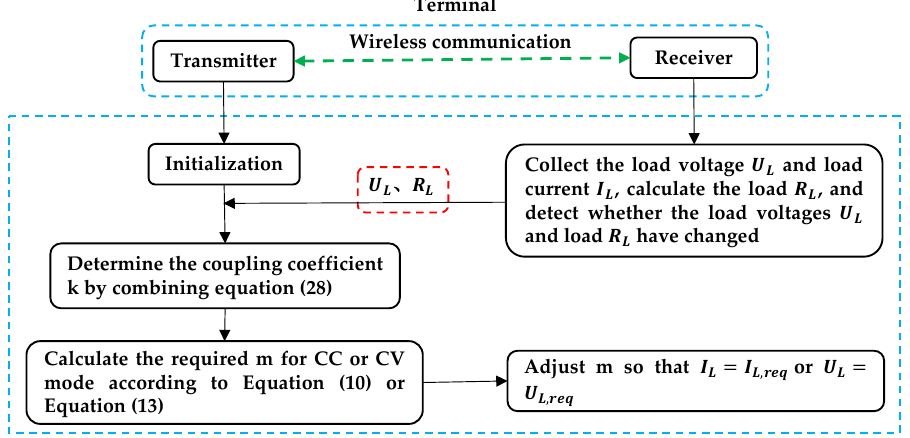
Figure 6. CC/CV output control strategy based on coupling-coefficient estimation.